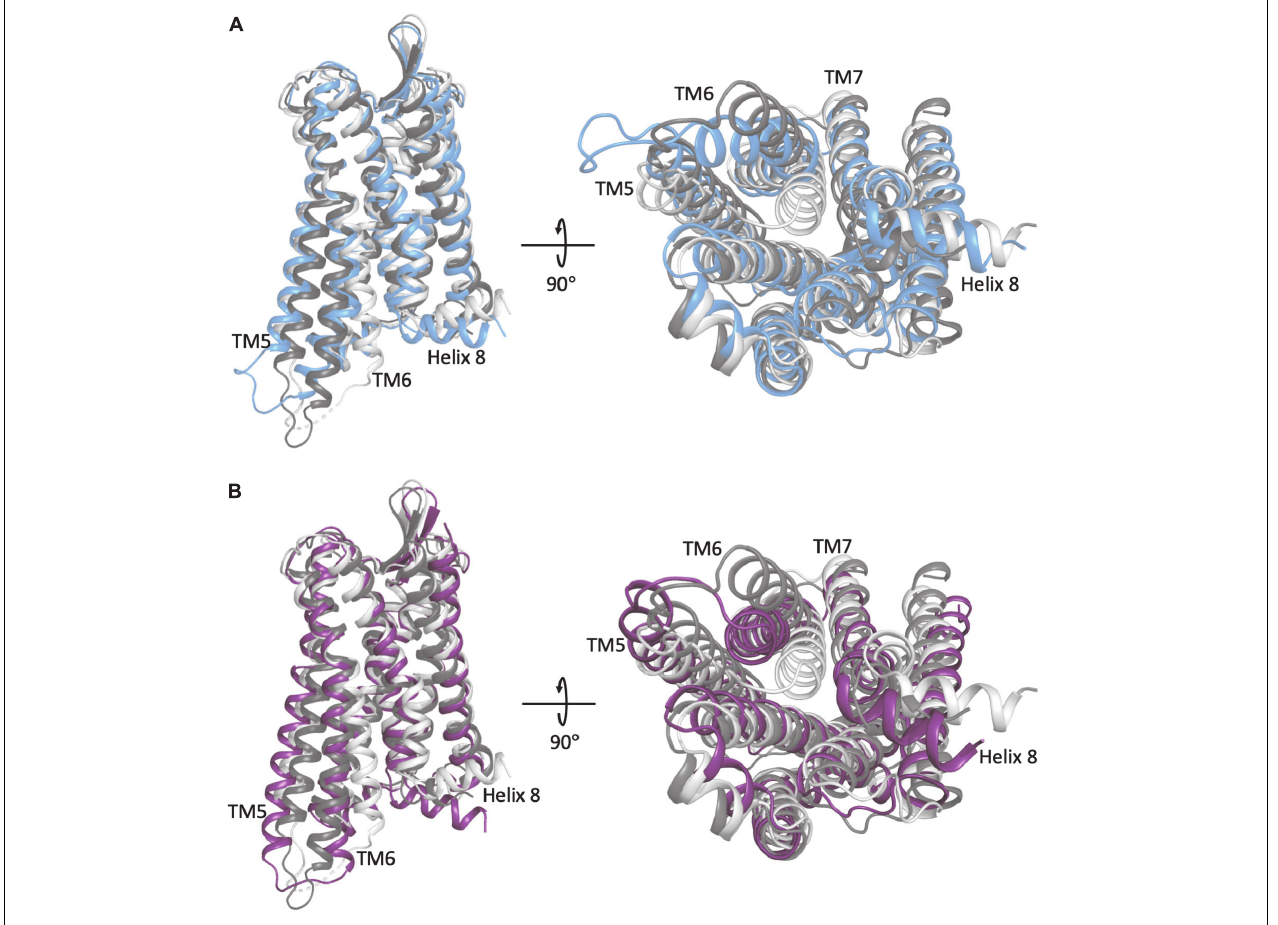
FIGURE 1 | A comparison of the representative conformation of the most probable metastable state within an intermediate region of (A) the morphine-bound MOP receptor, where the intermediate state is in light blue, and (B) the TRV-130-bound MOP receptor, where the intermediate state is in light purple, relative to the experimentally determined MOP receptor inactive and active states (light and dark gray, respectively). Note that the most dramatic differences between these conformations stem from the extent of outward movement of TM6 away from TM3, which is one of the most notable conformational changes that has been associated with receptor activation. Images on the right correspond to a 90 ◦ rotation of the receptor helical bundle, and represent the view from the intracellular